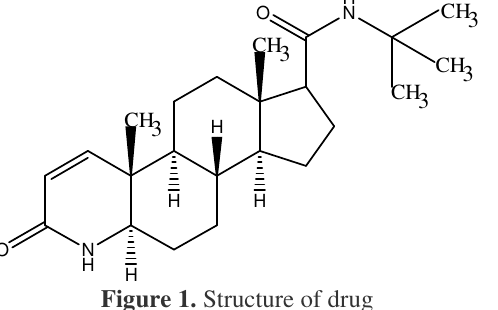
Figure 1. Structure of